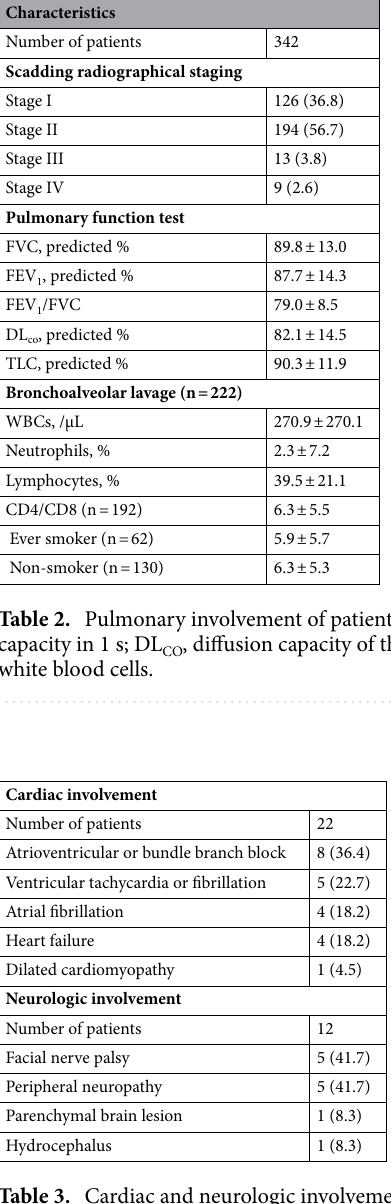
Table 3. Cardiac and neurologic involvement of patients with